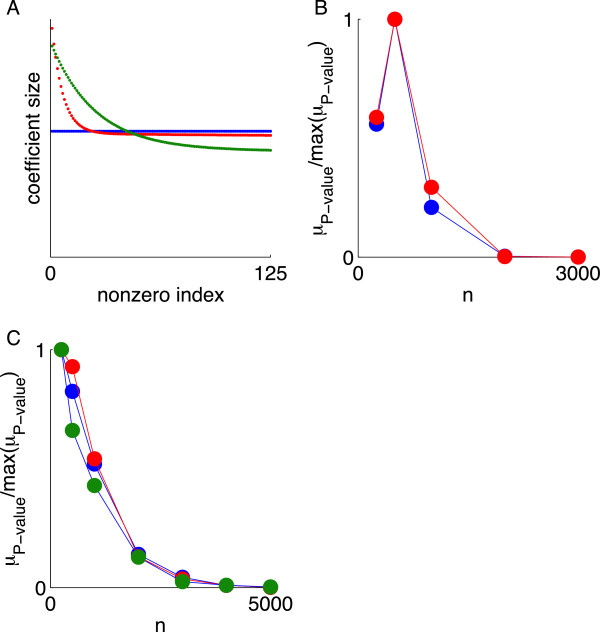
Insensitivity of the selection phase boundary to the distribution of coefficient magnitudes (ensemble). (A)s = 125 coefficient magnitudes (“effect sizes”) ordered from large to small for the Uniform (blue), Hyperexponential 1 (red), and Hyperexponential 2 (green) ensembles. (B) Chromosome 22 analysis using μP − value to measure selection (normalized by the maximum value) as a function of sample size for h2 = 1 for the Uniform (blue) and Hyperexponential 1 (red) ensembles. (C) As in panel (B) except for h2 = 0.5. Also shown is recovery for the Hyperexponential 2 ensemble (green).